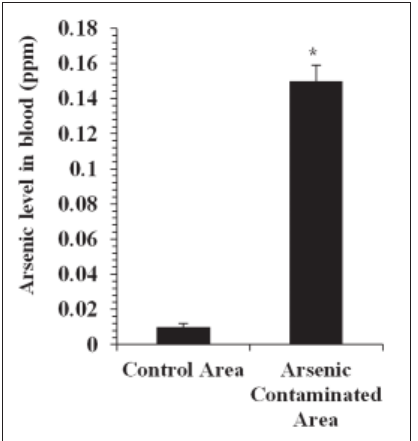
Figure-1: Total arsenic level (mean±SE) in buffalo blood samples collected from control (n=20) and arsenic contaminated (n=25) area. *Indicates significant difference at p<0.05. Note: Normal limit of arsenic in bovine blood is 0-0.05 ppm